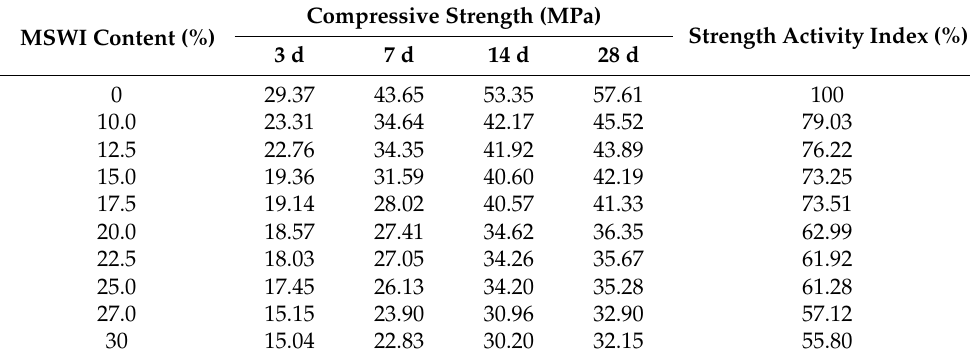
Table 5. Compressive strength of MSWI-recycled